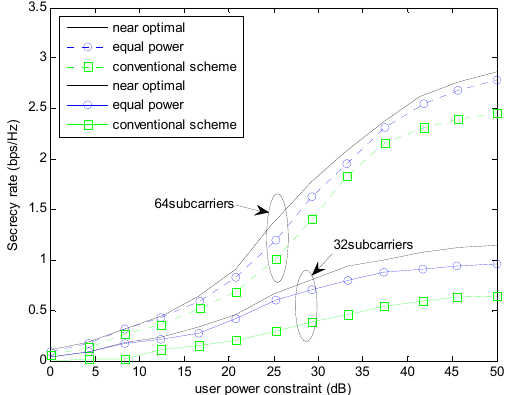
Figure 3. Secrecy spectral efficiency versus user transmitting power.